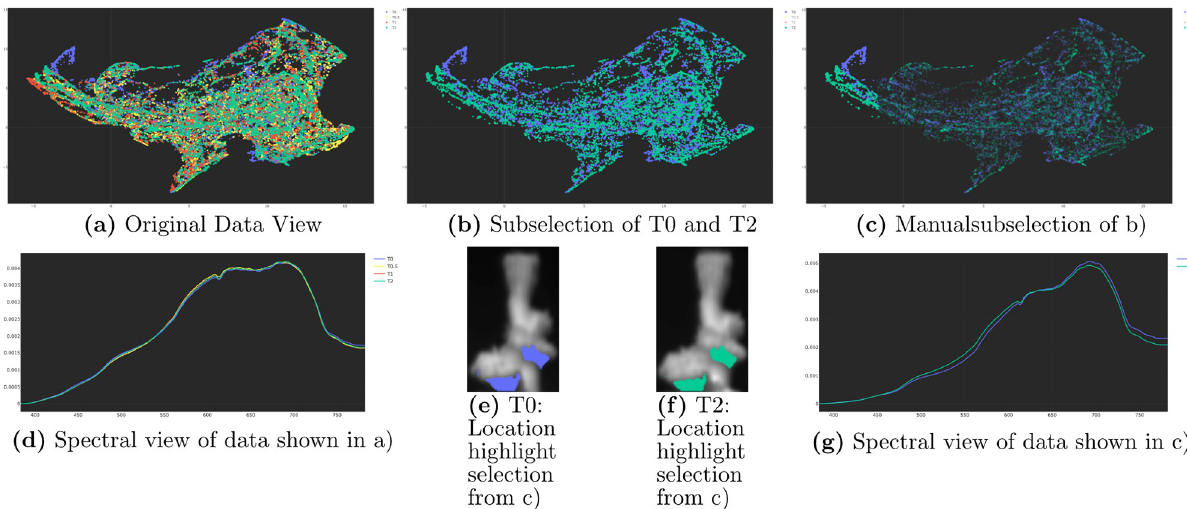
Fig 3. Local changes revealed with the interactive subselection of the hyperspectral viewer, otherwise shadowed by global analysis. Shown is the bentonite sample with 100 mg � L − 1 concentration using a UMAP with cosine metric and coral 3. The normalization of spectra was activated and the aggregation option was set to